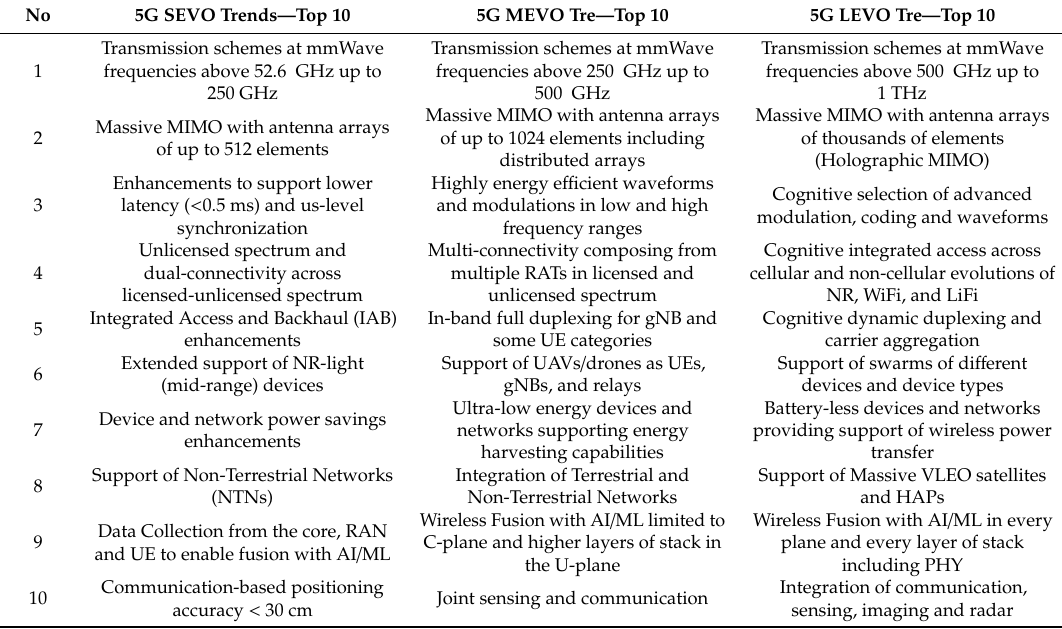
Table 3. Wireless technology trends for 5G SEVO, MEVO and